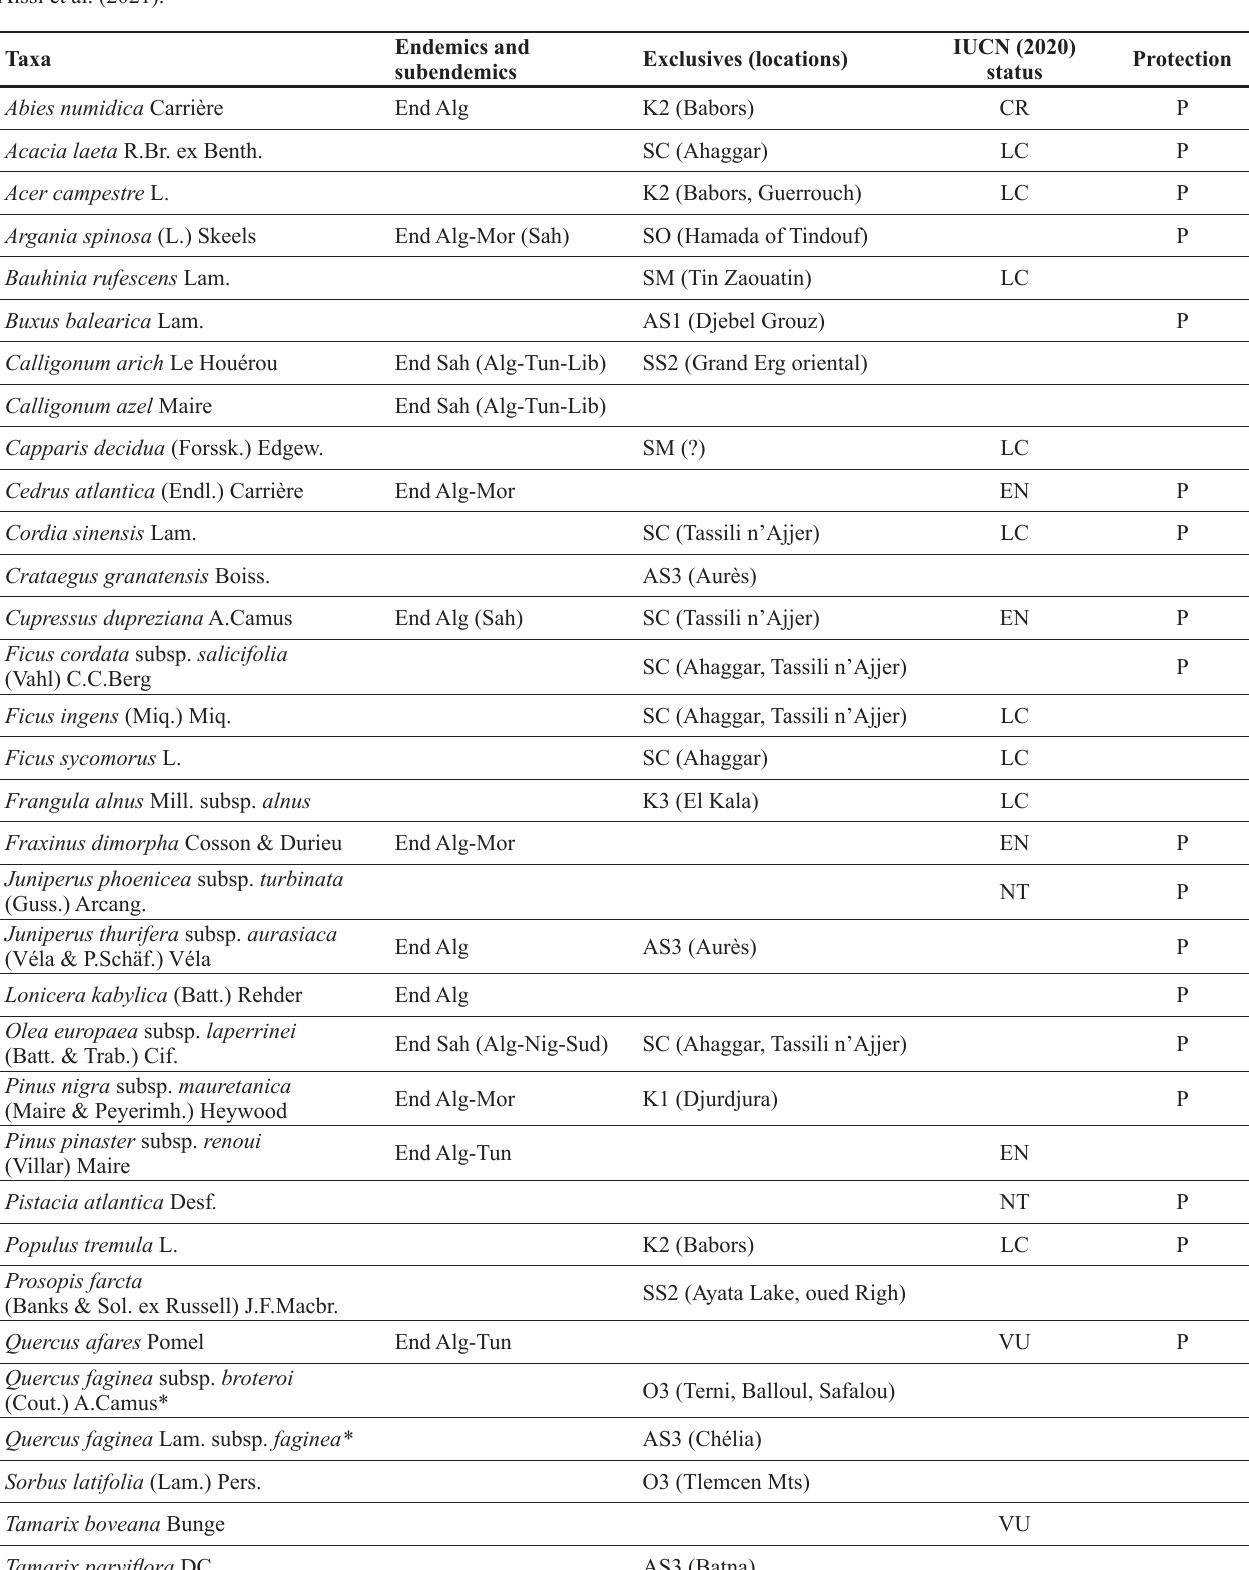
Table 6 – List of the tree taxa with patrimonial value (endemics and/or exclusives) that are threatened and protected at national level or not. Abbreviations. End: Endemic; Alg: Algeria; Mor: Morocco; Tun: Tunisia; Lib: Libya; Nig: Niger; Sud: Sudan; Sah: Saharan. *According to Aissi et al.